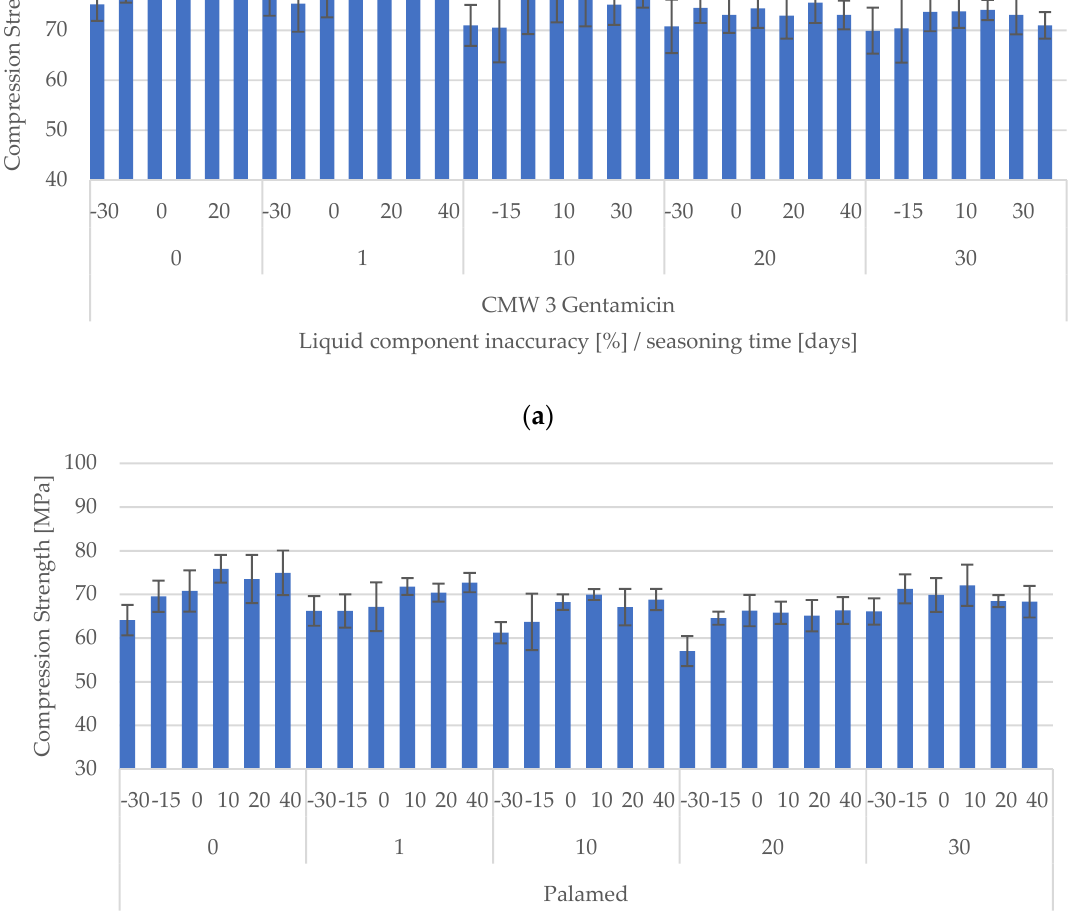
Figure 5. Summary results of compressive strengths of tested cements in relation to composition ( a ) DePuy CMW3 Gentamicin and ( b )